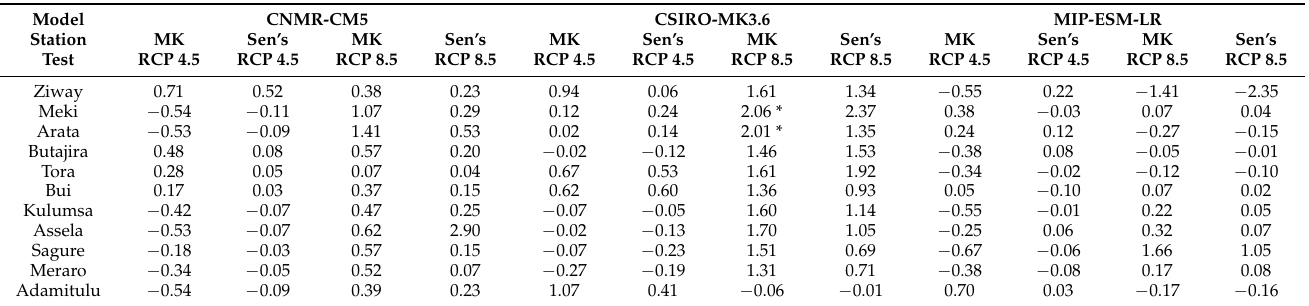
Table 3. Projected Mann–Kendall trend and Sen’s slope estimator results average rainfall for eleven stations within the Ziway Lake Basin for the period 2026–2049.